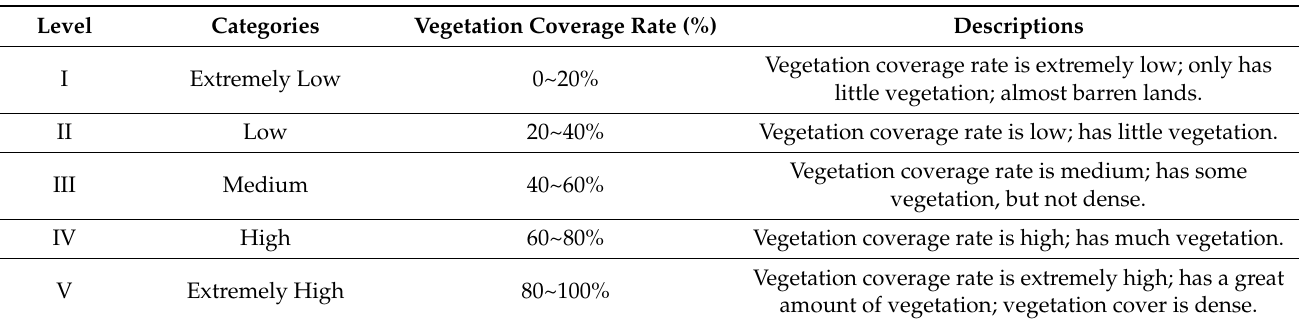
Table 1. Classification of vegetation